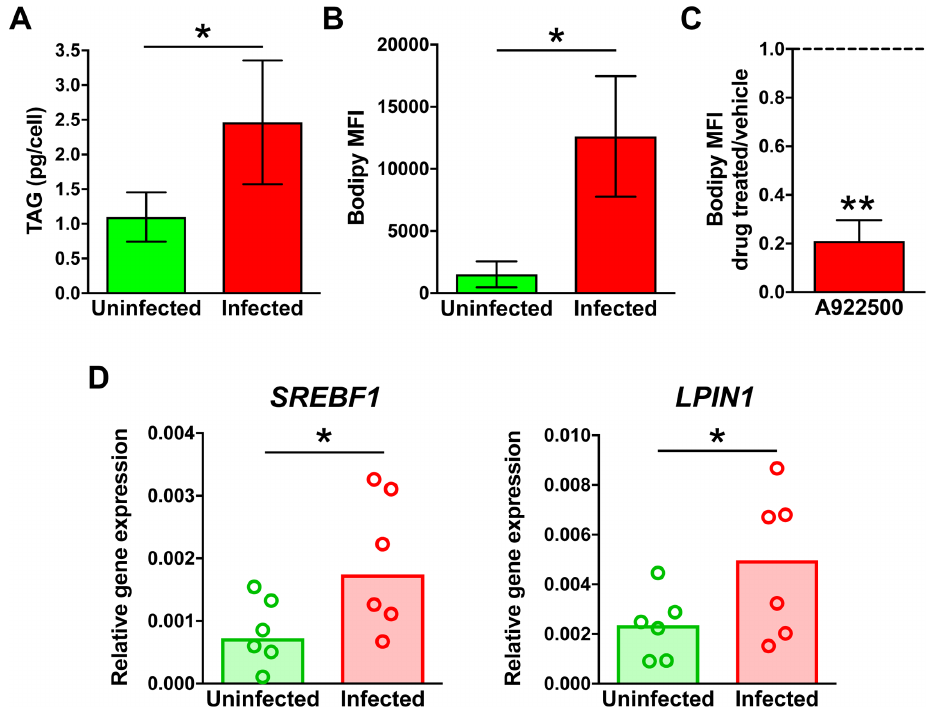
Fig 3. TAG and lipid droplet levels, and expression of TAG metabolism genes in macrophages infected with M . tuberculosis in vitro. Human monocyte-derived macrophages (MDM) were infected with M . tuberculosis for 24 h or left uninfected. Infected cells were treated with either DMSO (vehicle control) or A922500 (DGAT inhibitor). ( A ) TAG measurement by mass spectrometry. Lipids were extracted from uninfected and infected cells, and TAG species quantified by LC-MS. ( B ) Lipid droplet content determination by imaging flow cytometry. Uninfected and infected macrophages were stained with Bodipy 493/503 and imaged by ImageStream X Mark II imaging flow cytometer at 60× magnification. Images were analyzed by IDEAS software and lipid droplet content was expressed as median Bodipy fluorescence intensity per cell (MFI) (the baseline measurements in uninfected cells reflect the scanty lipid droplet induction occurring during macrophage differentiation in vitro). ( C ) Effect of A922500 on lipid droplet content. Lipid droplet content of infected macrophages was determined as described. Results were expressed as ratio between inhibitor- and vehicle-treated cells. In A , B , and C , average and standard deviation of three donors are shown. ( D ) Gene expression analysis. RNA was isolated from uninfected and infected cells, and mRNAs enumerated by qPCR using gene-specific primers and molecular beacons (S5 Table). Gene expression was calculated using the 2 - ΔΔ Ct method and normalized to the housekeeping ACTB gene. Graphs show the medians of six donors, with each dot representing one donor. Statistical significance ( (cid:3) p < 0.05, (cid:3)(cid:3) p < 0.01) was assessed by paired (panels A , B , and D ) and one-sample (panel C ) student t-tests. The comparisons in the paired tests are as indicated; the comparison in the one- sample student t-test was between treated and untreated cells. SREBF1 encodes SREBP-1c, a transcription factor that functions as master regulator of TAG biosynthesis [106]; LPIN1 encodes LIPIN1, a TAG biosynthetic enzyme [107] that also functions as transcriptional coactivator of SREBP-1c